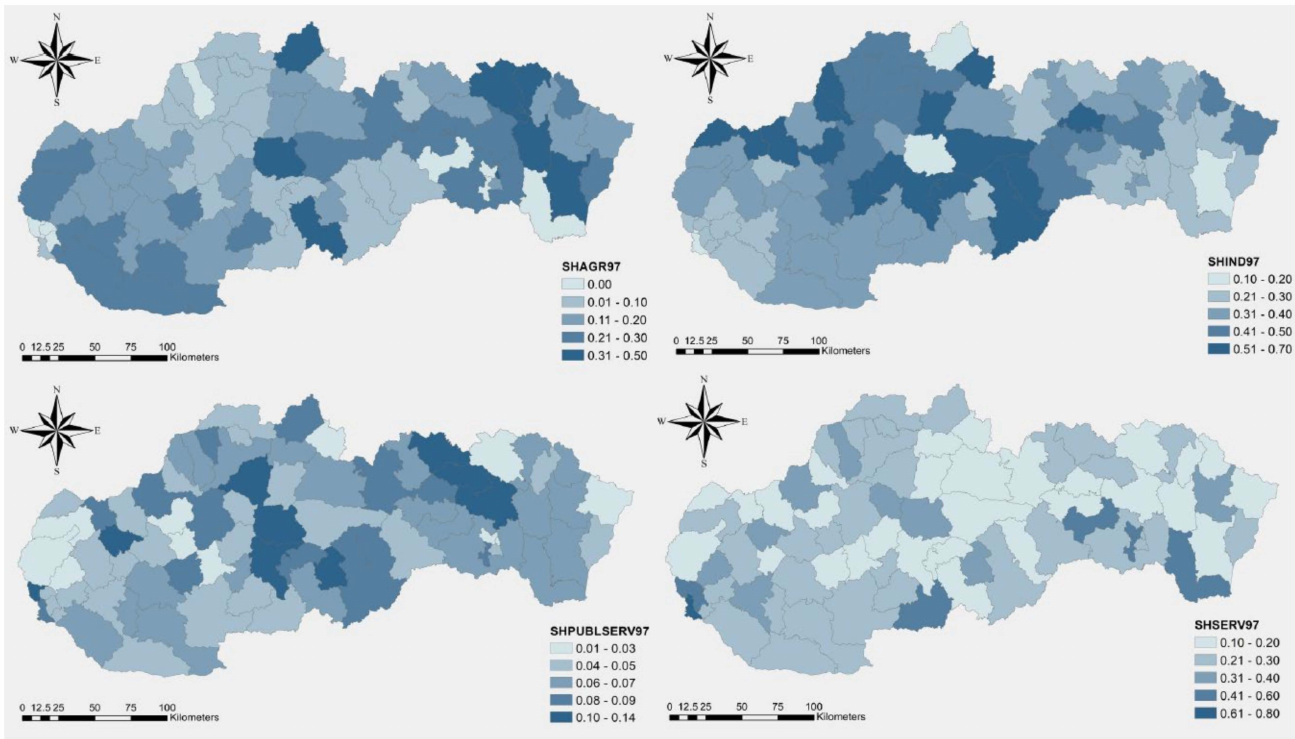
Figure 4. Share of agriculture, industry, services and public services in total employment—1997 (%). Source: [78] Rusn á k and Lehock ý